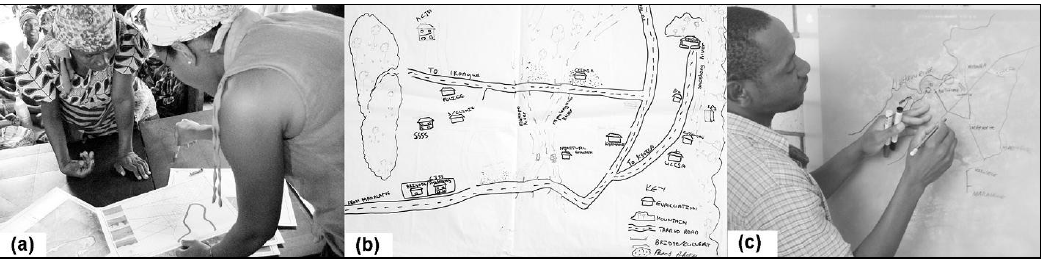
Figure 7. Different mapping techniques: ( a ) Mozambique; ( b ) Botswana; ( c ) South Africa.